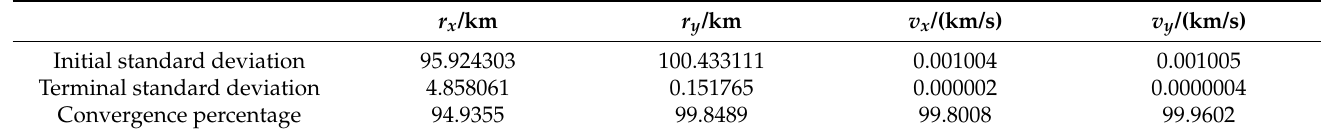
Table 2. Analysis of the 3-sigma curve of the 1th orbital